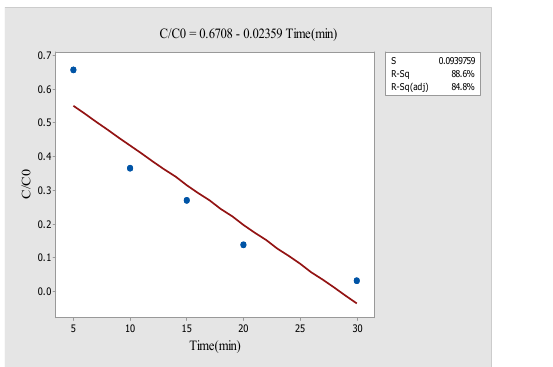
Fig. 13. Second-order reaction kinetic of removal of acid blue 113